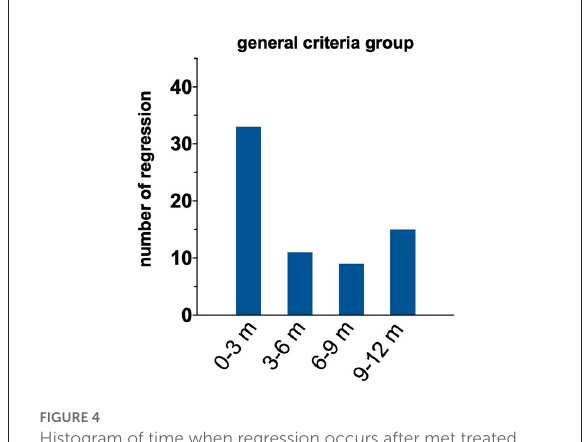
FIGURE4 Histogram of time when regression occurs after met treated